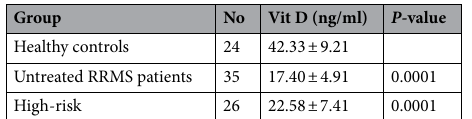
Table 4. The mean concentration of Vit D (25OH-D) ± SD in the experimental group.